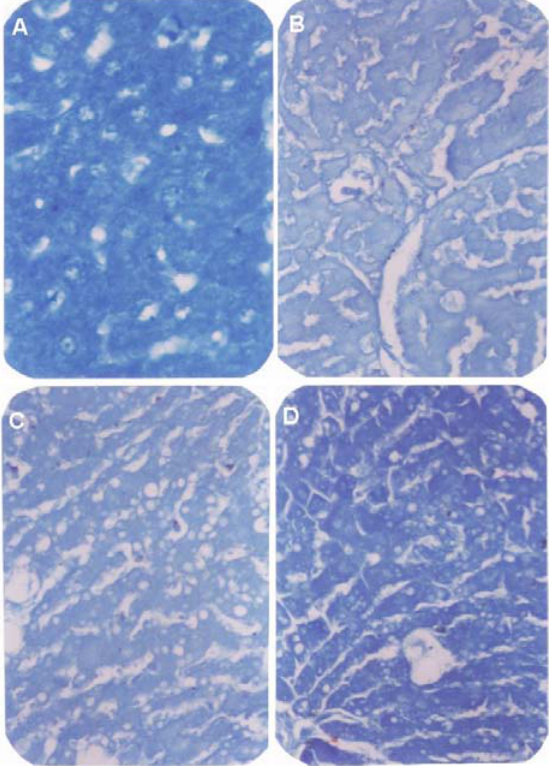
FIGURE 6. Section of liver stained with bromophenol blue showing greenish blue protein content in the cytoplasm of hepatocytes: (A) control (normal) rat; (B) CCl 4 -treated rat showing marked diminution of protein content; (C) CCl 4 + DDB (375 mg/kg)-treated rat showing moderate improvement in DNA content; (D) CCl 4 + DDB (75 mg/kg) + silymarin (22 mg/kg)-treated rat showing that protein content approximated control (Bromophenol blue stain x